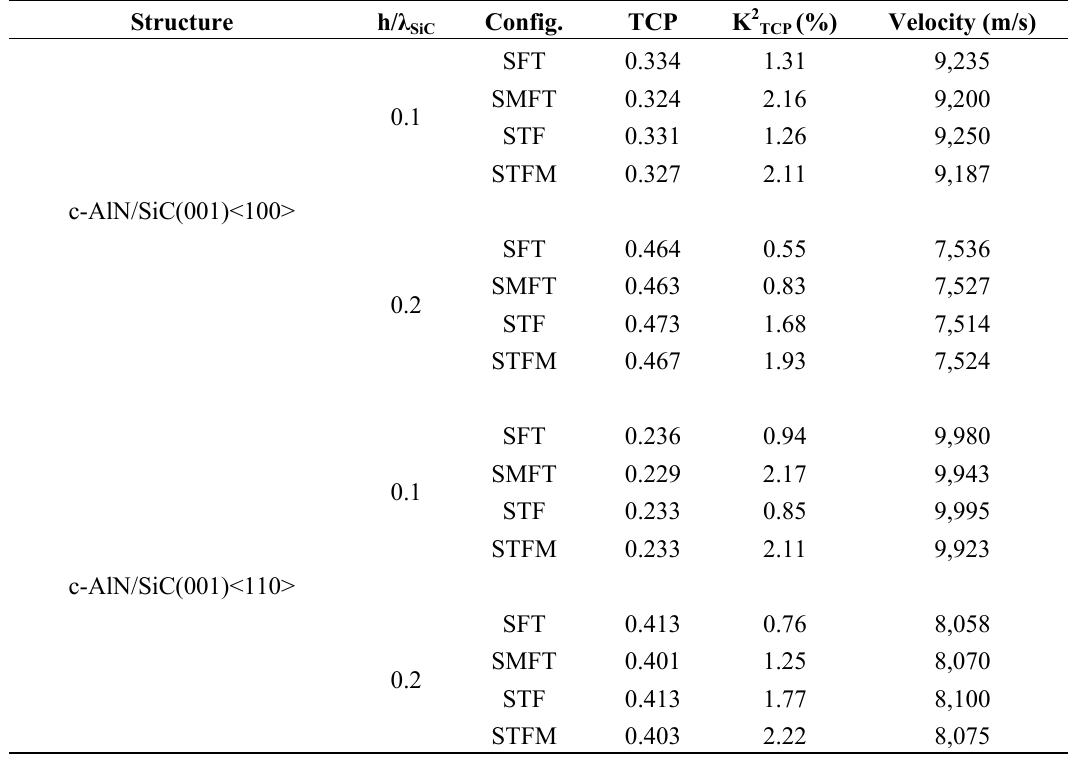
Table 2. The TCP of each configuration, the K 2 and phase velocity of the thermally compensated